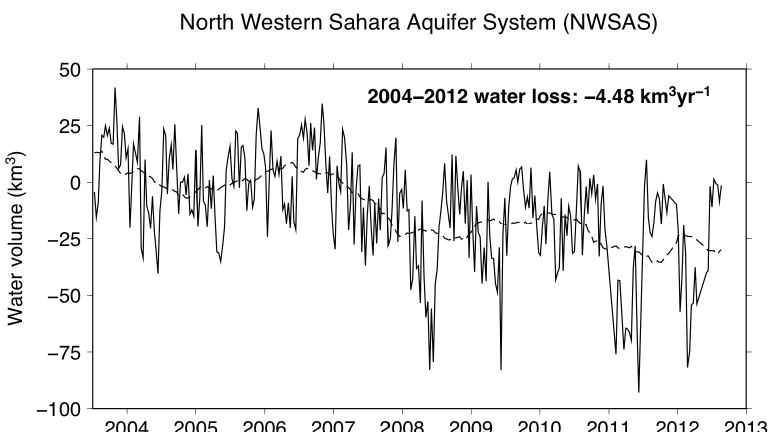
Figure 12. TWS time series over the NWSAS region (Libya-Tunisia-Algeria) aquifer (9 in Figure 1) (solid line) and the corresponding 13-month averaged profile (dashed